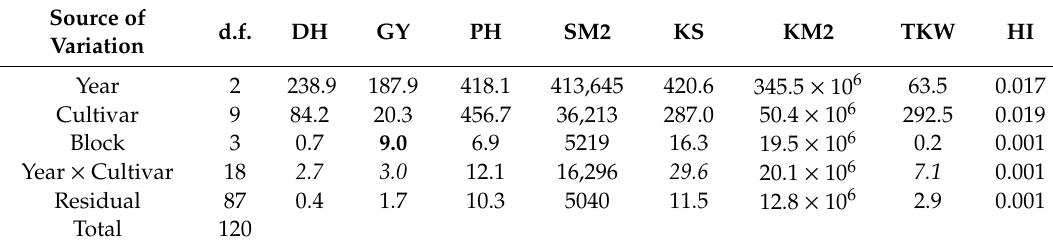
120 Level of significance is indicated in bold ( p < 0.01) and cursive ( p < 0.05). DH: Days to heading; GY: Grain yield; PH: Plant height; SM2: Number of spikes per m 2 ; KS: Kernels per spike; KM2: Kernel number per m 2 ; TKW: Thousand kernel weight; HI: Harvest index.